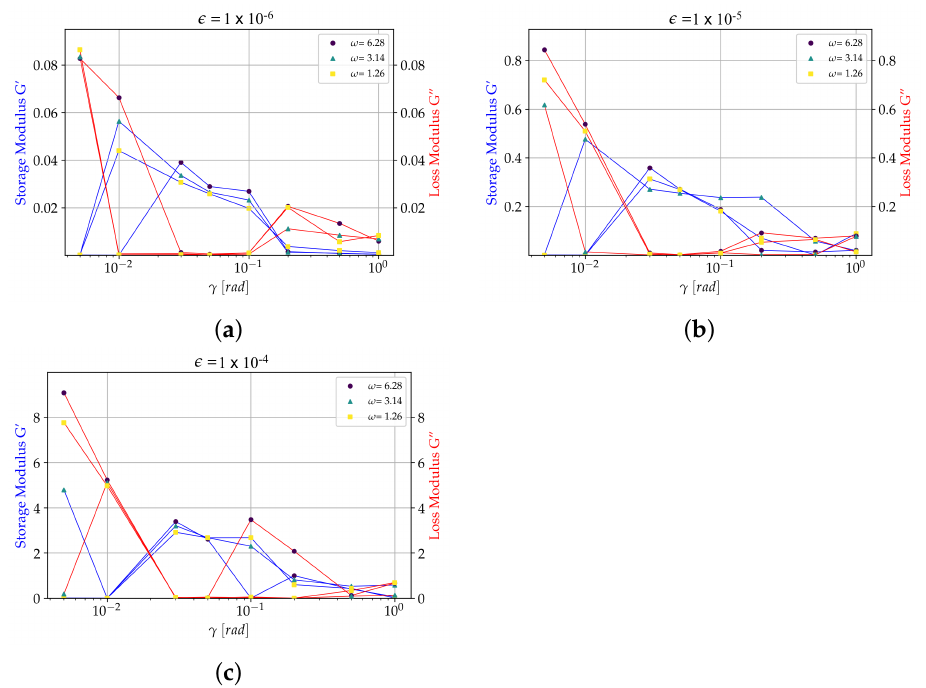
Figure 11. Storage and Loss moduli obtained with an exclusively elastic configuration of the proposed model. Blue: Storage modulus G (cid:48) , red: Loss modulus G (cid:48)(cid:48) . Tests obtained for 5 × 10 − 3 ≤ γ ≤ 1, and for oscillating frequencies ω = 1.26, 3.14, 6.28 rad s − 1 . ( a ) Results for (cid:101) CS = 1 × 10 − 6 . ( b ) Results for